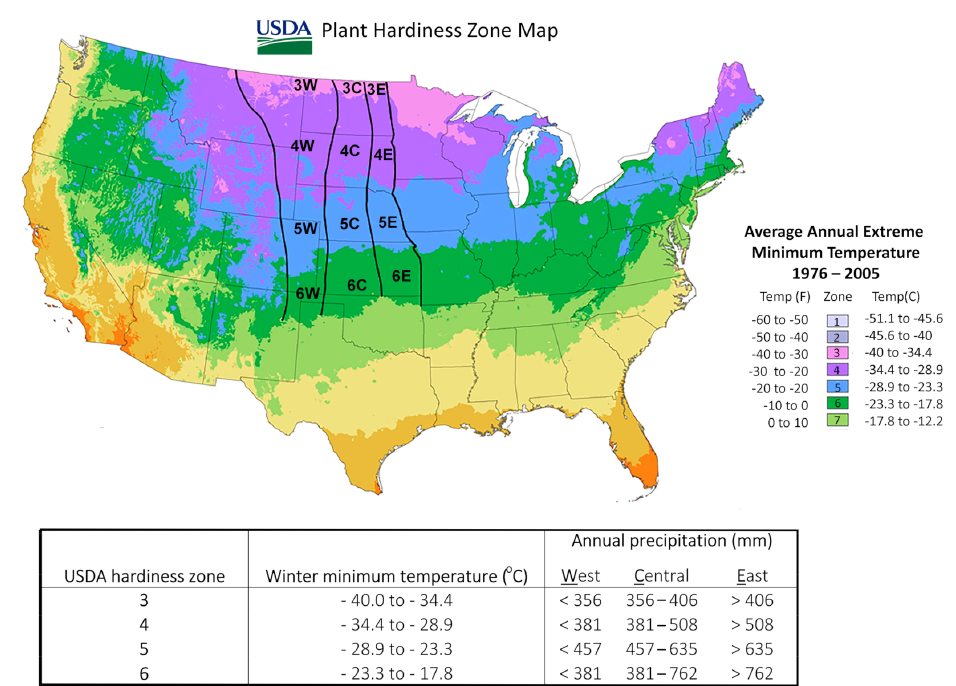
Figure 2. Twelve sub-regions delineated in Tree Advisor based on the 2012 USDA Hardiness Zone Map and PRISM 30 yr Normal Annual Precipitation: Period 1981–2010. Base map source